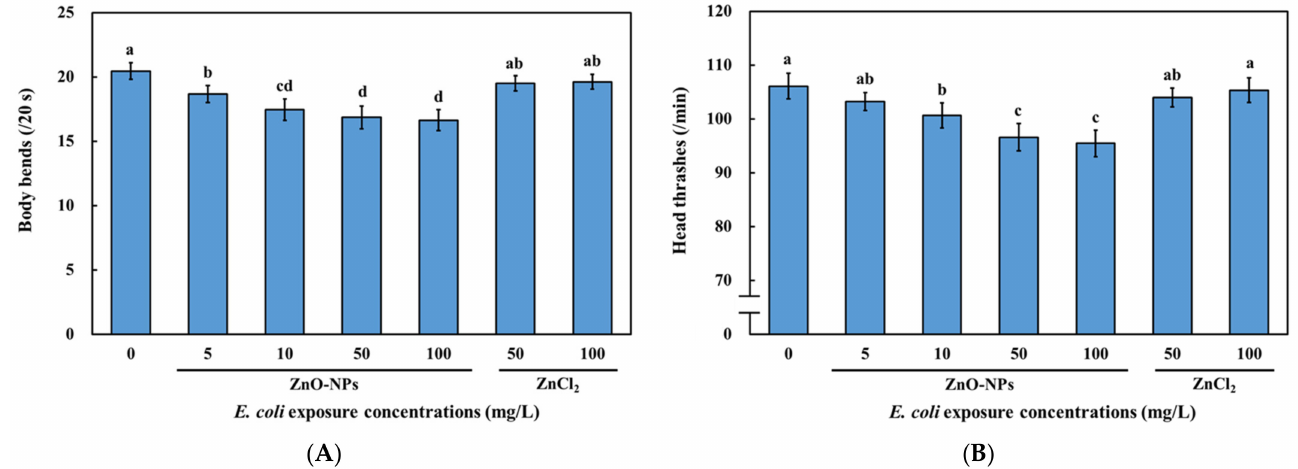
Figure 4. Locomotive behavior defects resulted from dietary transfer of ZnO-NPs in C. elegans. Wild-type N2 C. elegans L1-larvae were fed with ZnO-NPs or ZnCl 2 pretreated E. coli OP50 for 72 h. After exposure and washing, ( A ) body bends and ( B ) head thrashes of worms were determined. The data are shown as the mean ± SEM. The tests were conducted at least three times independently, and 20 worms were scored per treatment in each replicate. Statistical significance was determined by one-way ANOVA with LSD post-hoc test and indicated by different lowercase letters ( p <